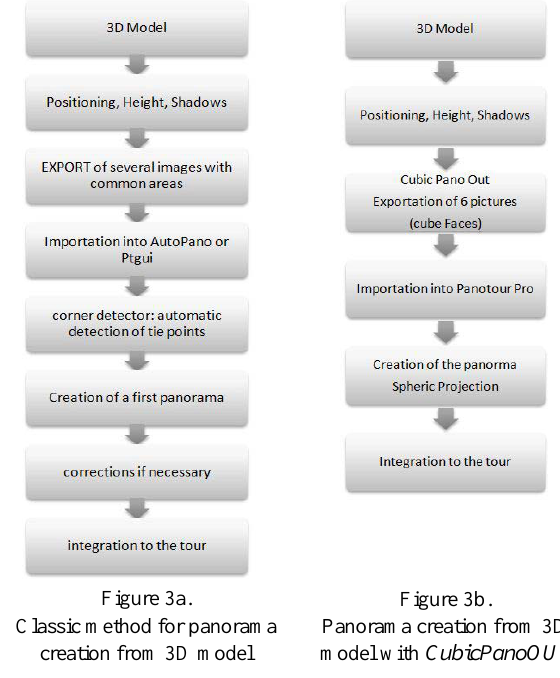
Classic method for